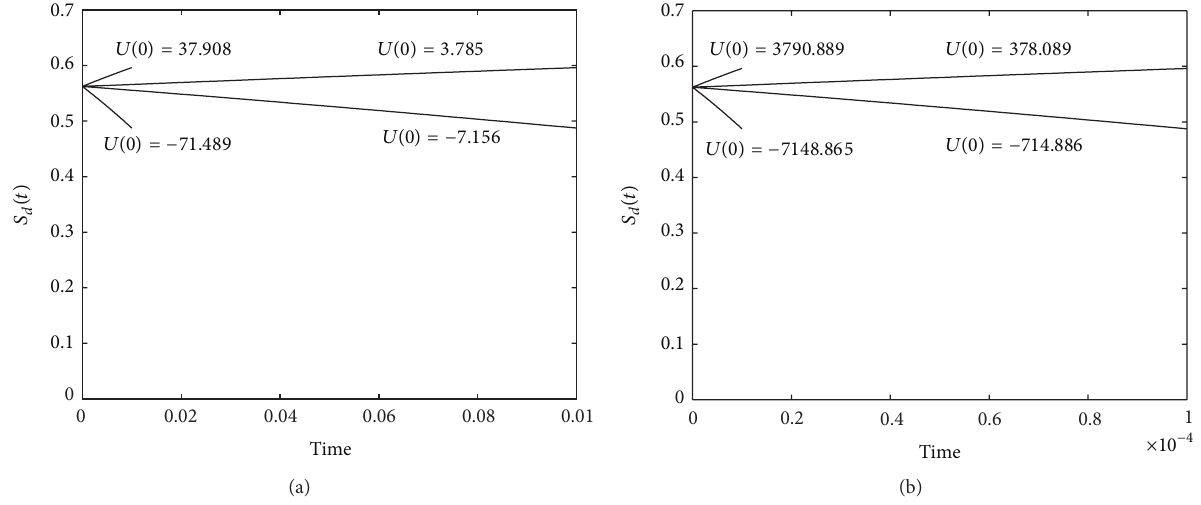
Figure 4: Evolutions of the entropy for system (69) with initial state 𝐶(0) = [√3/2, 1/2] and 0.00001.